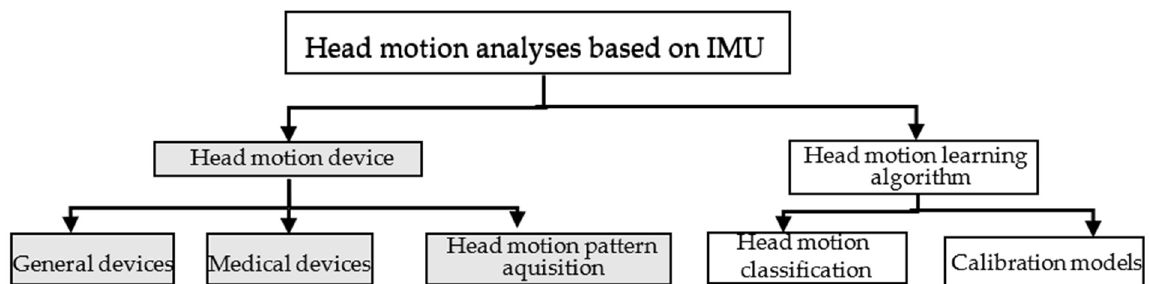
Figure 1. Taxonomy of head motion recognition applications.